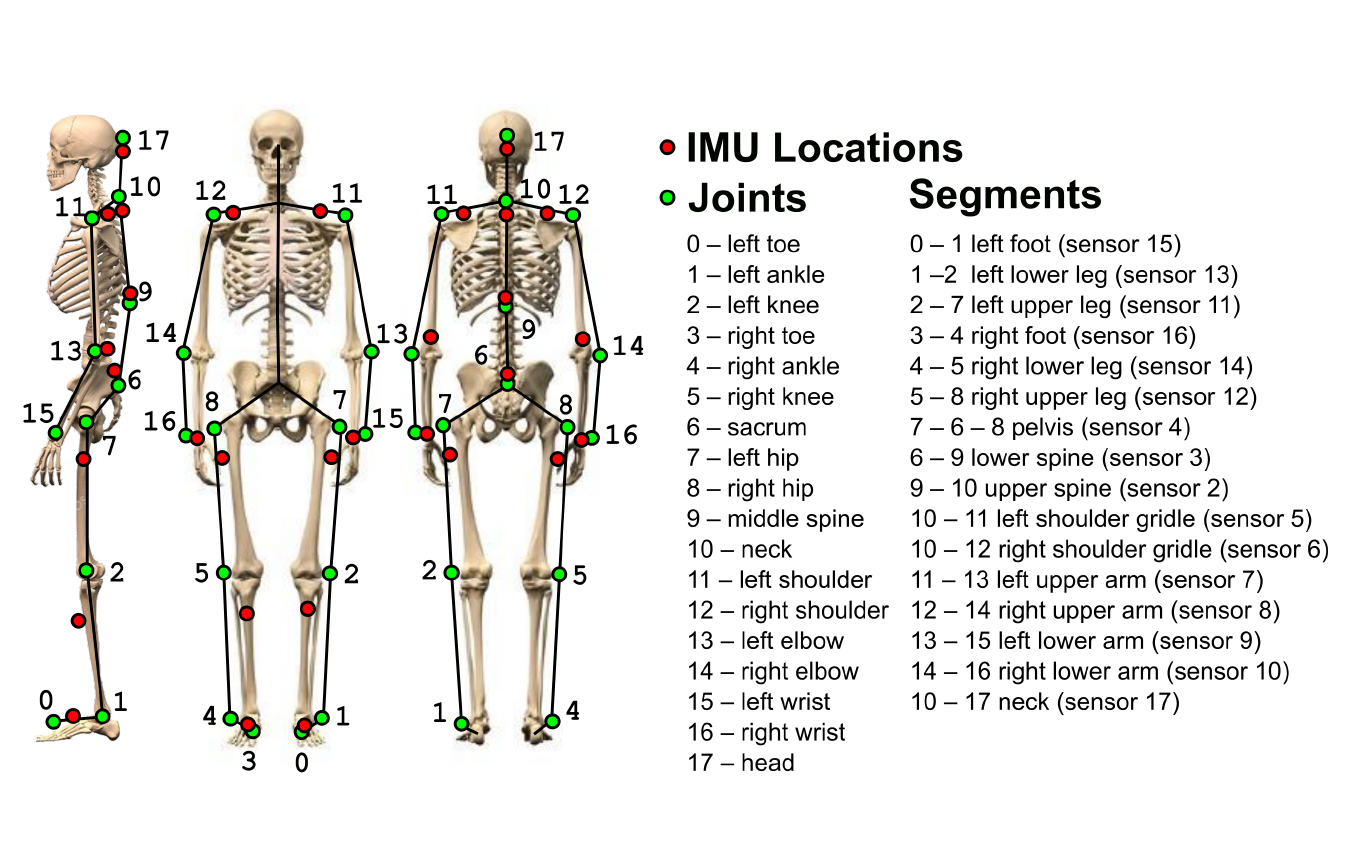
Figure 6. Human body approximation